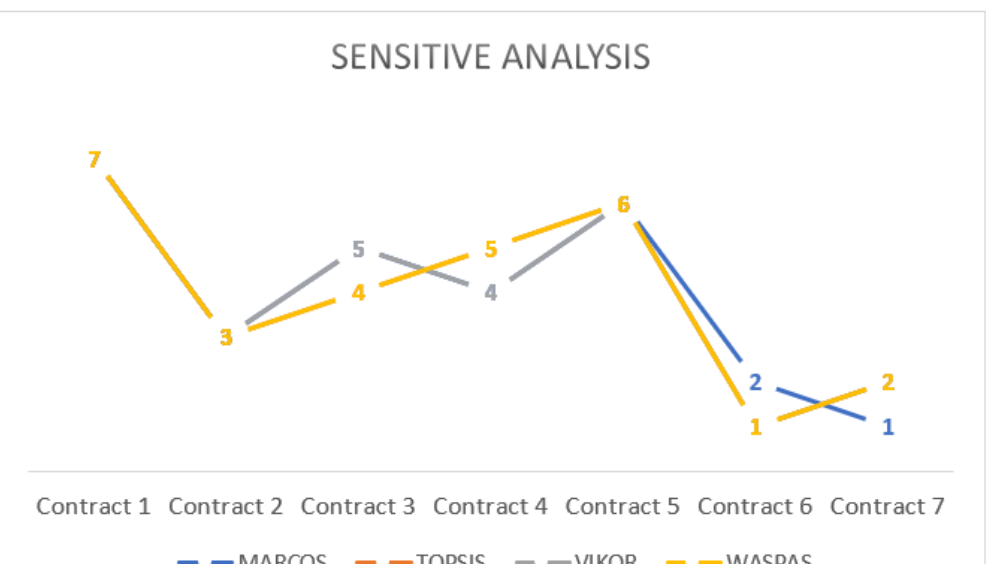
Figure 5. Sensitive analysis.